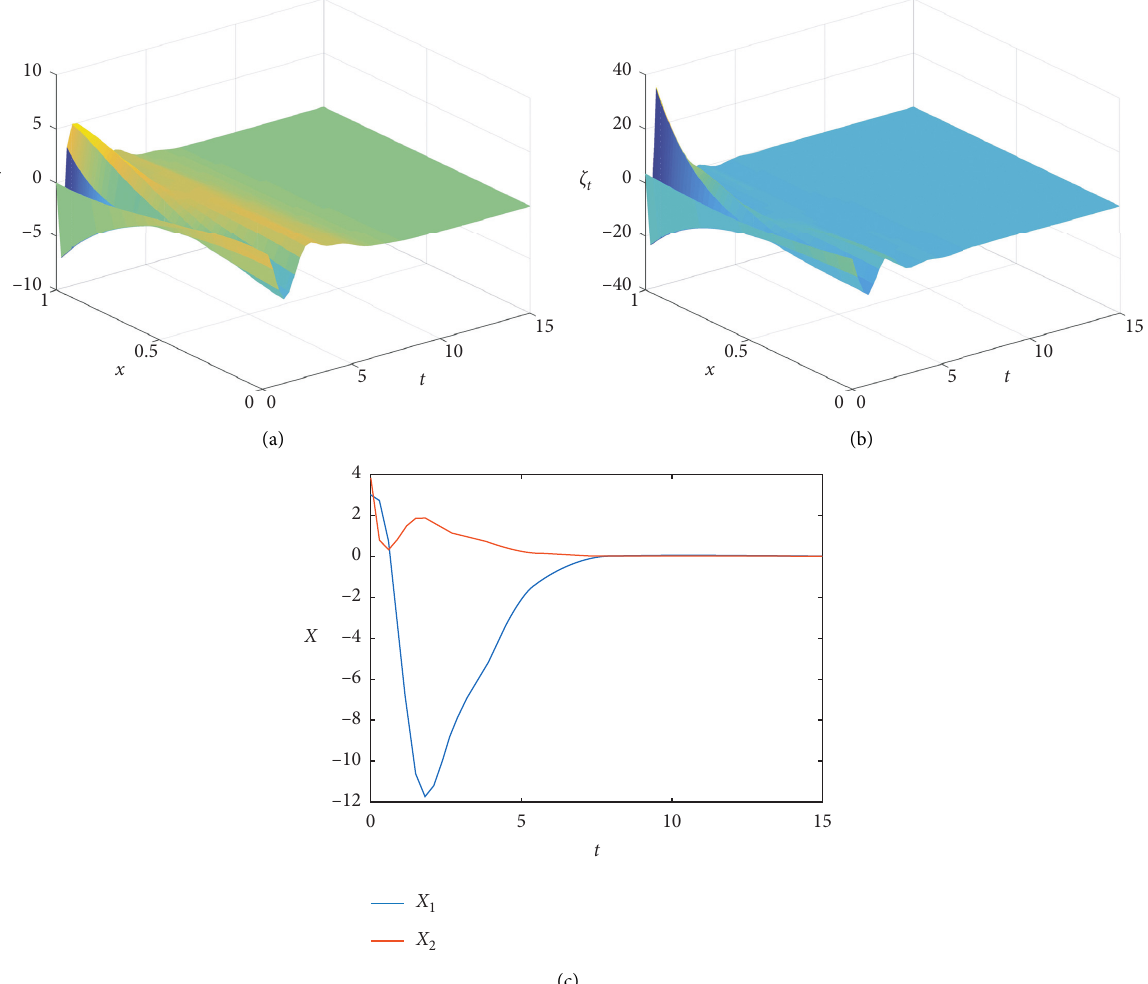
Figure 1: Solution of “ ( X, ζ , ζ ) part” in the closed-loop system (58). (a) Displacement of the ζ -part. (b) Velocity of the ζ -part. (c) X t